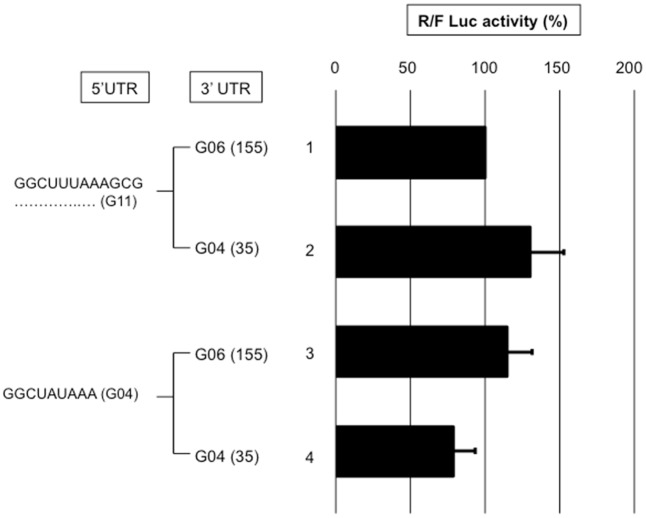
Comparison of 3'UTRs from genes 4 and 6 on NSP3-dependent translation efficiency.BSRT7 cells expressing NSP3 were electroporated with the standard RNA and capped R-RNA with the 5'UTR from gene 11 (lines 1,2) or 4 (lines3,4) combined with the 3’UTR from gene 6 (lines 1,3) or 4 (lines 2,4). The Renilla and firefly luciferase activities were measured 6 hours after electroporation. The ratio of Renilla to firefly luciferase activities is reported relative to the control (line 1), which was considered 100. The data are the mean ± SEM of three independent experiments in triplicate. A Student’s t-test was used (*p<0.05;**p<0,01).